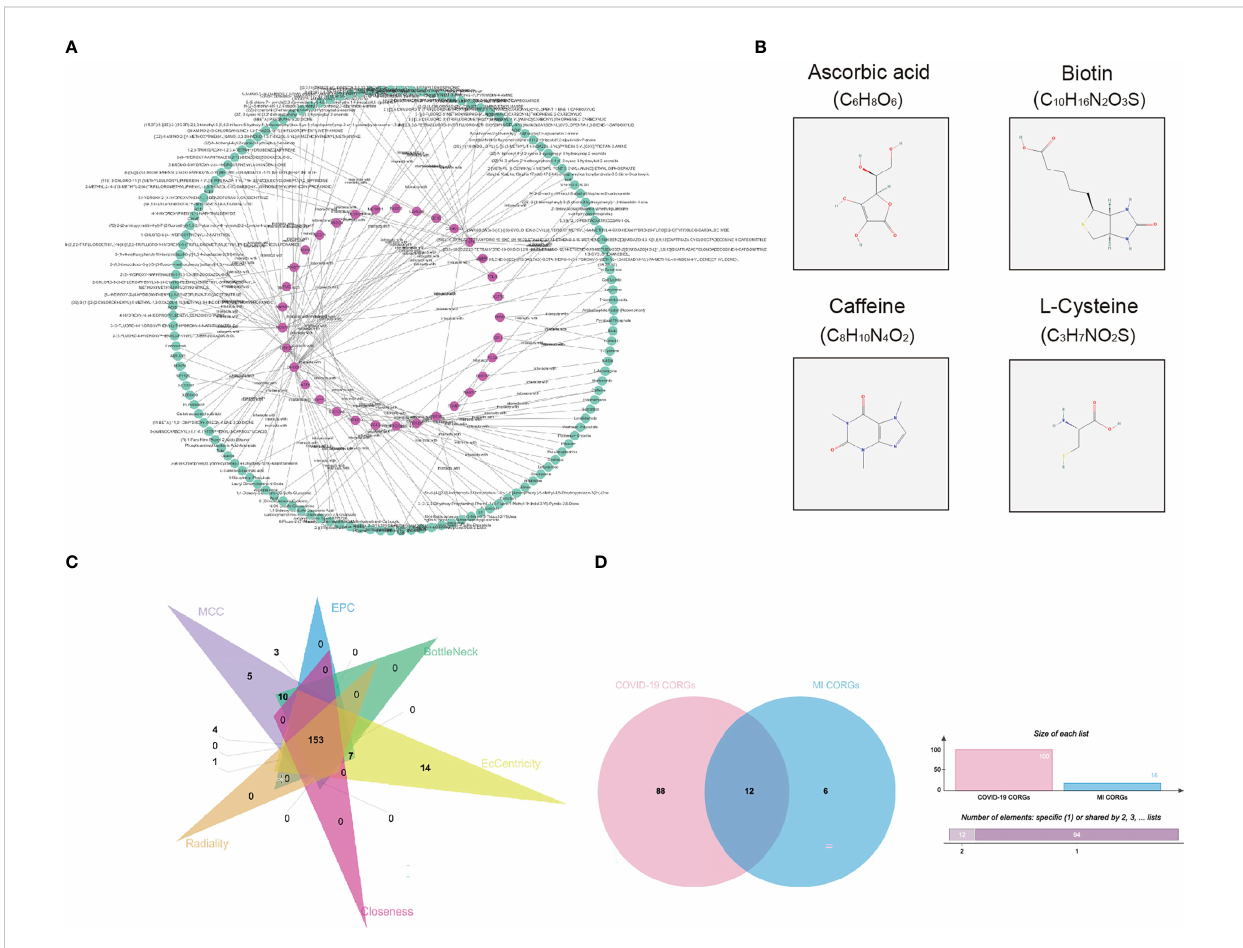
(C) Venn diagram depicts the overlapped CORGs in the connectivity ranking analysis (MCC, EPC, BottleNeck, EcCentricity, Closeness, and Radiality). (D) Venn diagram depicts the signi fi cant overlapped CORGs with AUC > 0.9 in both the COVID-19 dataset and MI dataset. CORGs,